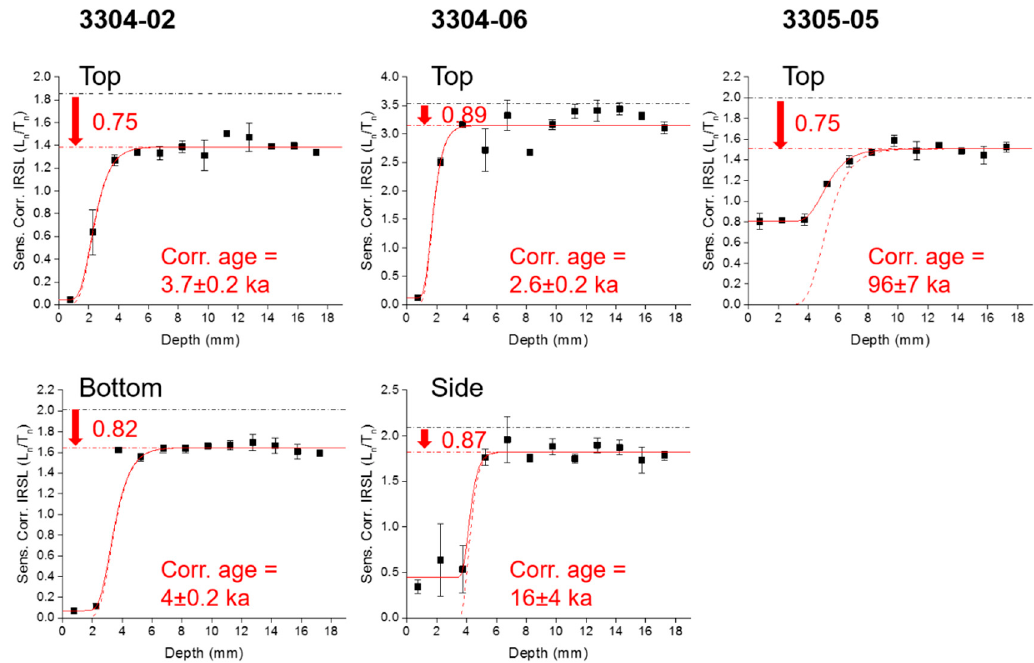
Figure 5. Luminescence profiles from apparently well-bleached surfaces. The best fit of the model by Sohbati et al. [54] is shown as a solid line and the predicted latent luminescence profile at the time of burial is shown as a dashed line. The black and red dash-dot lines represent the laboratory and field saturation limits, respectively. The field-to-laboratory saturation ratios shown next to arrows provide an upper limit to fading and were used to correct the ages after Rades et al. [63].